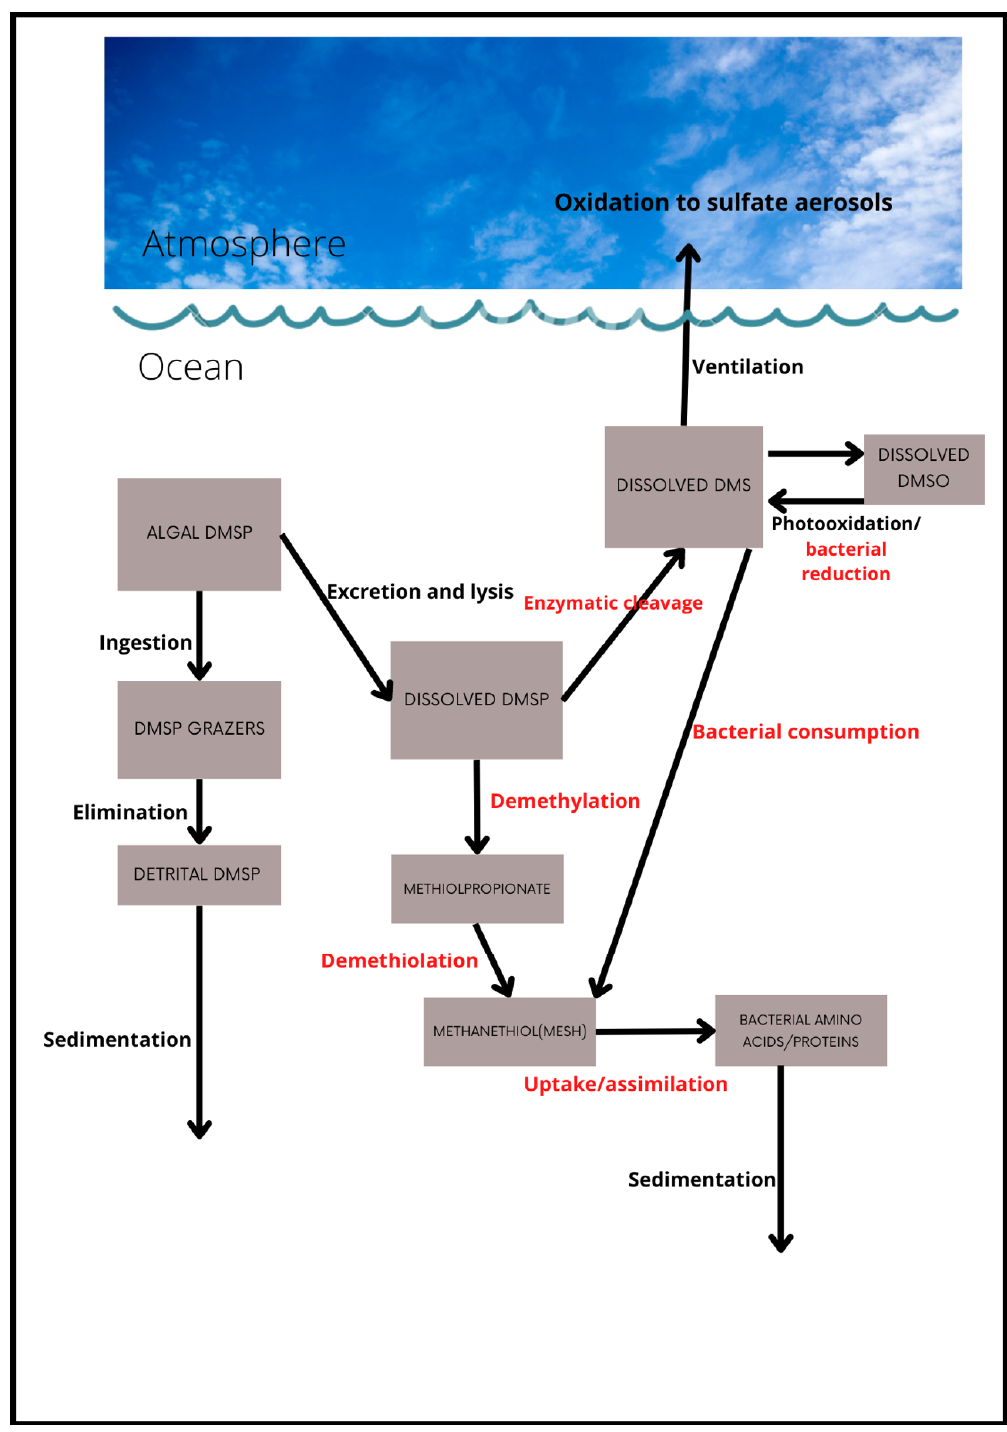
Figure 1. Simplified schematic representation of the dimethylsufide (DMS) and dimethylsulfoniopropionate (DMSP) cycles. Red-colored processes indicate those that are mediated by heterotrophic bacteria. DMSO: dimethylsulfoxide.